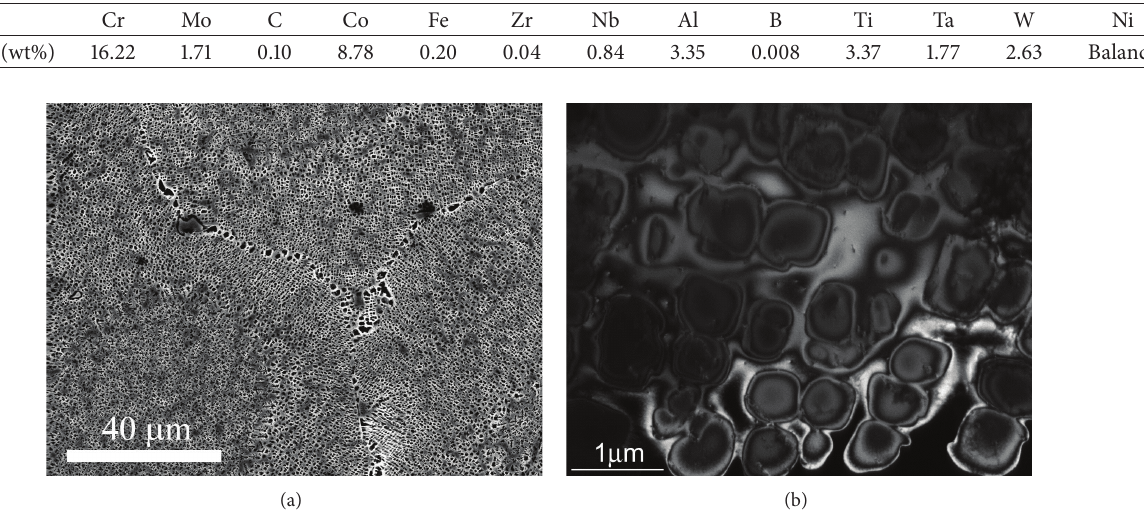
Table 1: The composition of IN738LC superalloy [12].